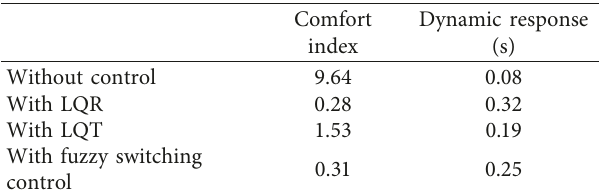
Figure 13: Derivative of acceleration (jerk) comparison. Table 3: Evaluation of vehicle comfort and dynamic response with the proposed controls.